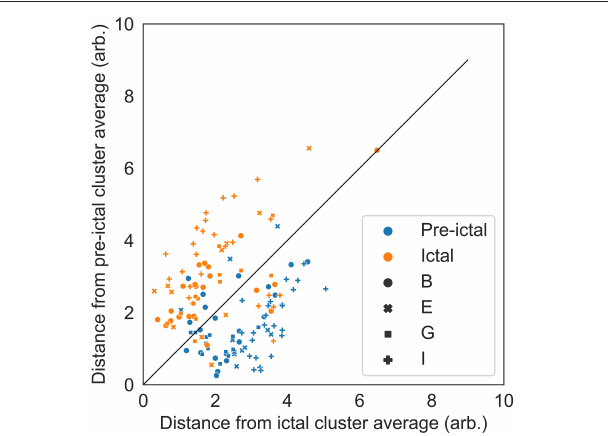
FIGURE 3 | Distance-to-ictal-cluster-average vs. distance-to-preictal- cluster-average for all ictal and pre-ictal periods to illustrate the separation capability. Distances are to person-specific cluster averages, calculated as Euclidean norms in the reduced feature space. The solid black line represents the class separation. The separation accuracy was 83.8%. Period is shown with different colors (blue are pre-ictal periods and orange are ictal periods) and the subject ID is shown with different marker types (circles, crosses, squares and plusses are persons B, E, G, and I,